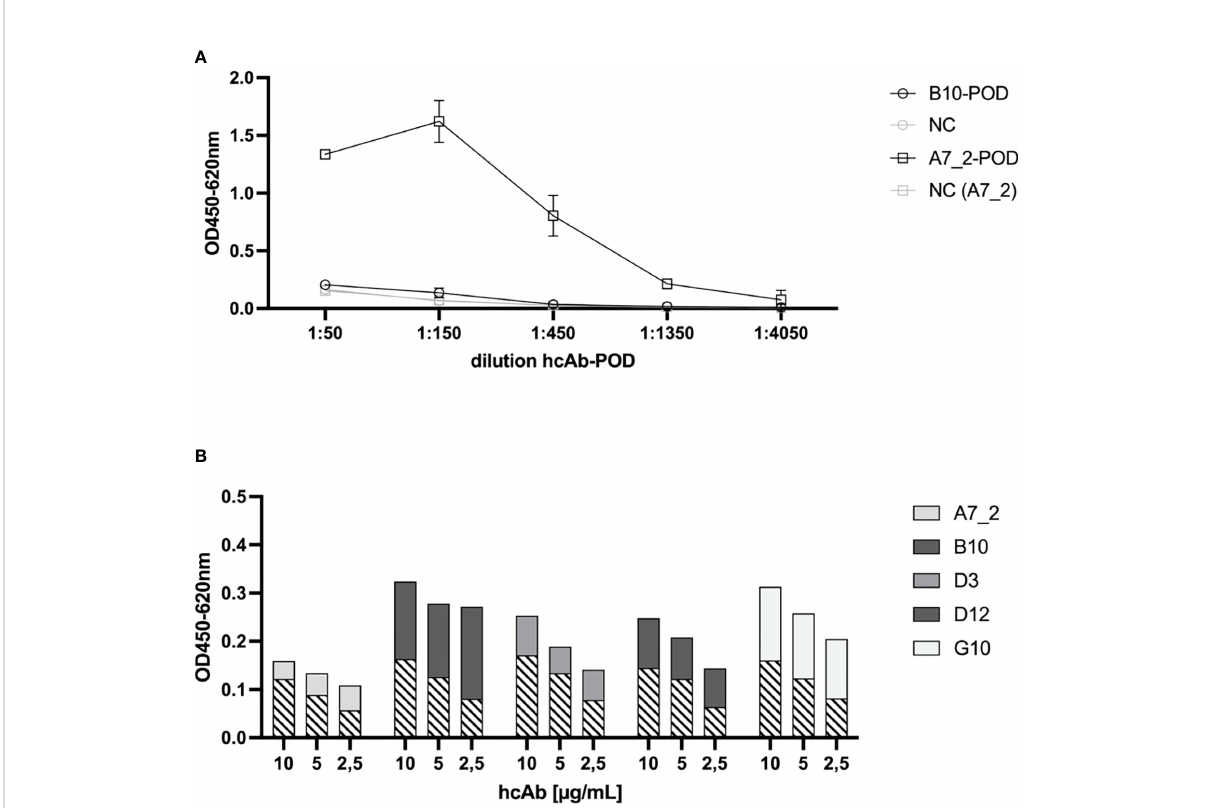
FIGURE 3 Sandwich Immunoassay setup for the detection of recombinant SARS-CoV-2 Spike protein. (A) HRP-conjugation of hcAbs B10 and A7.2. HcAbs B10 and A7.2 were conjugated with HRP to serve as secondary antibody in a sandwich ELISA. To detect the HRP conjugation, SARS-CoV-2 Spike protein was coated on the solid phase (1 µg/mL). HRP-conjugated hcAb B10 and A7.2 were added in different dilutions. Binding was detected by adding TMB substrate solution and optical density was measured at 450 nm with a reference wavelength of 620 nm. Mean and standard deviation of two independent measurements is shown. (B) Sandwich ELISA of hcAb candidates in different pairwise combinations. Puri fi ed hcAbs were coated on the solid phase in different concentrations of 10, 5 and 2.5 µg/mL. SARS-CoV-2 Spike protein was added (2.5 µg/ mL). HcAb A7.2 was applied as HRP-conjugated secondary antibody in a dilution of 1:1600. Detection of optical density was performed at 450 nm with a reference wavelength of 620 nm. Cross-hatched areas represent the background value for negative control (coated blocking solution instead of